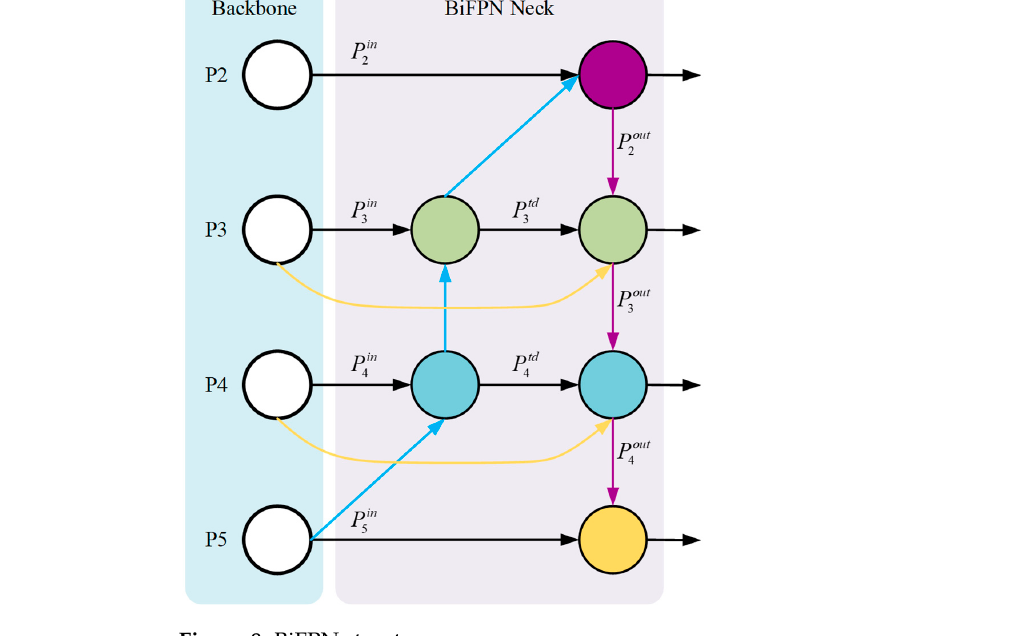
Figure 8. BiFPN structure.